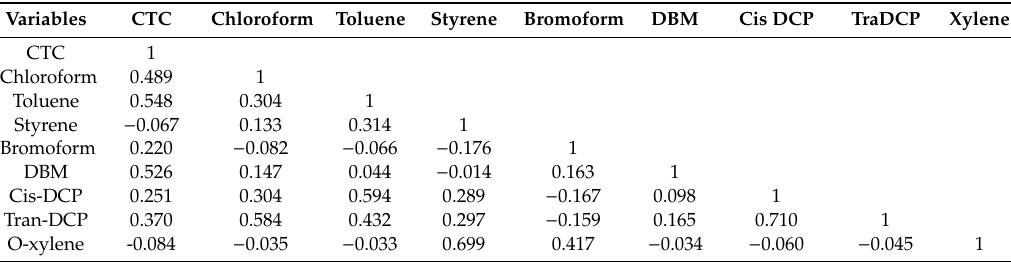
Table 7. Correlation matrix Pearson (n) for VOCs in drinking water samples.